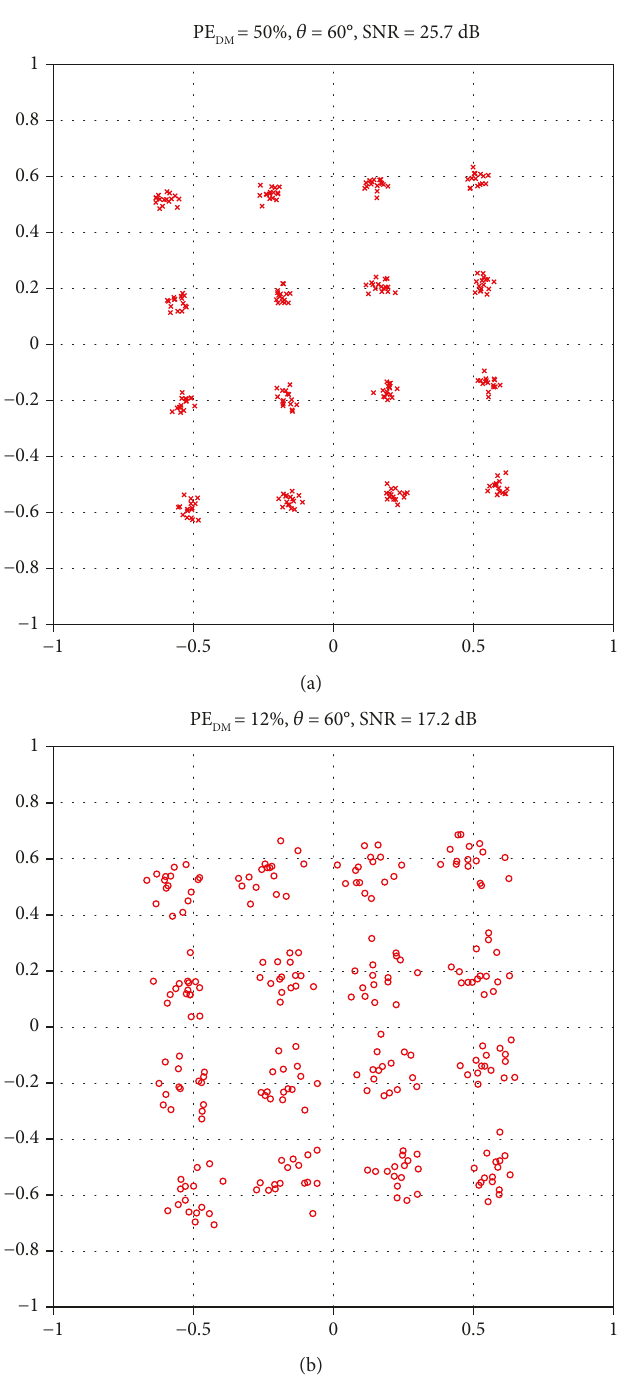
Figure 8: DDM 16-QAM modulation transmitted at the secure direction 60 ° using real components and (12) to compute S modulators. (a) PE DM = 50% . (b) PE DM = 12%